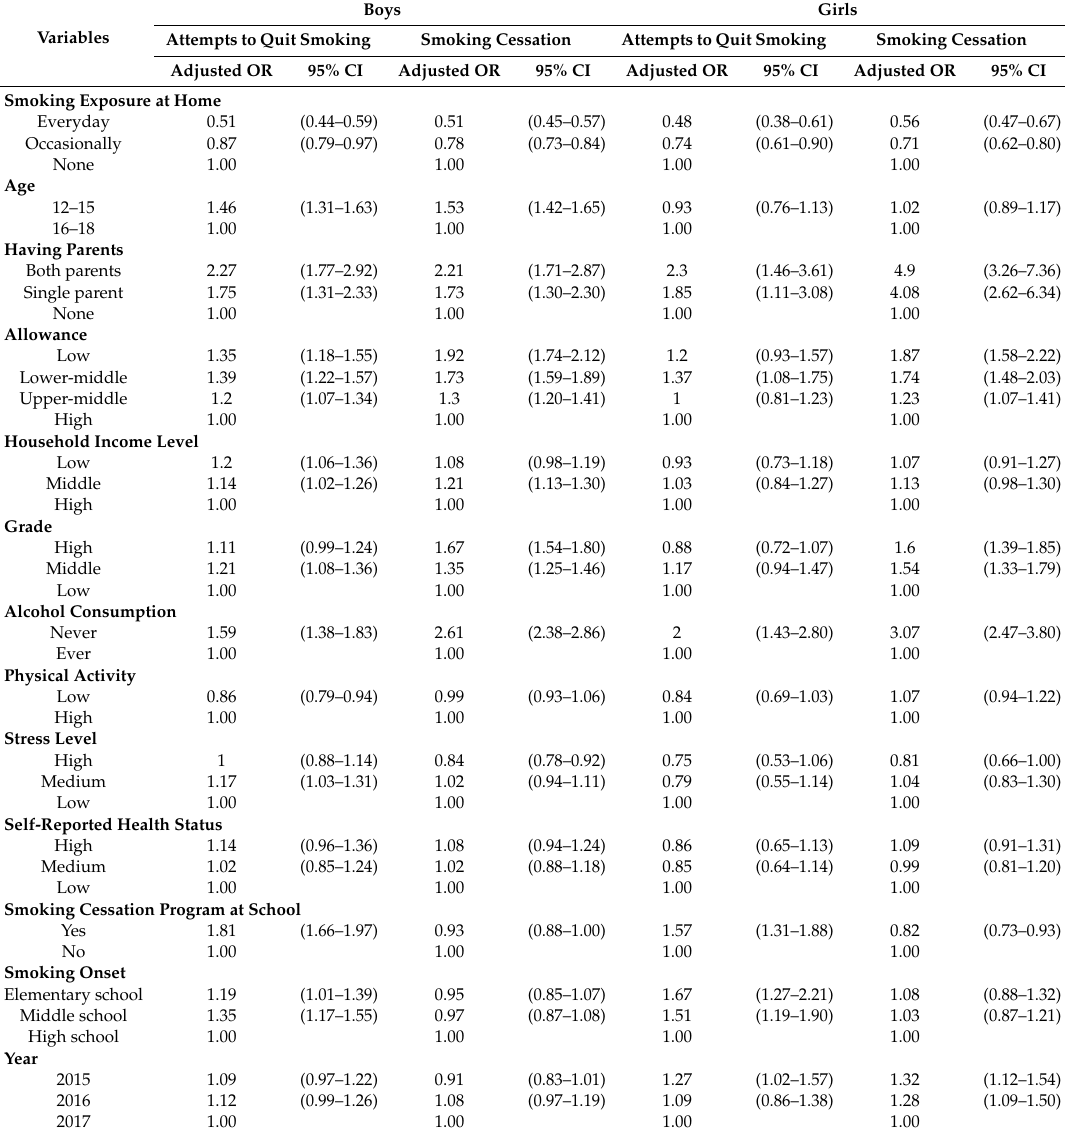
Table 2. Factors associated with attempts to quit smoking and smoking